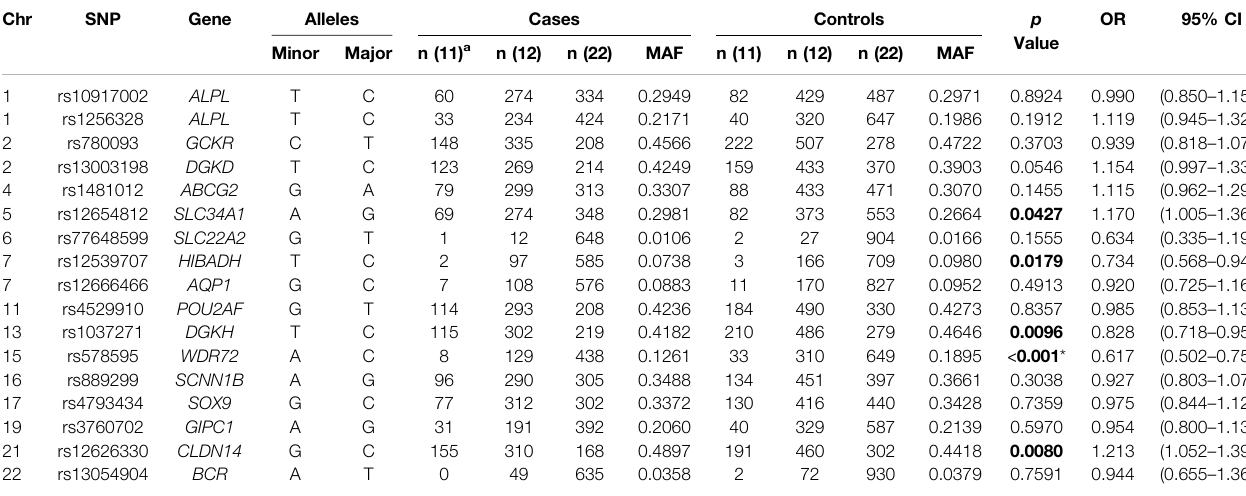
TABLE 2 | Results of association analysis for calcium nephrolithiasis in Chinese Han population. Chr